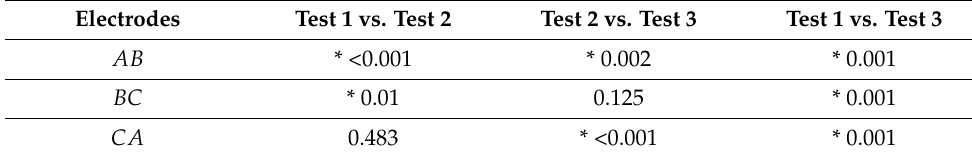
Table 4. p -value obtained from Student’s t -test comparing oR _max under different working conditions (Test 1, Test 2 and Test 3) for the three pairs of electrodes (AB, BC and CA). The asterisk indicates significant p